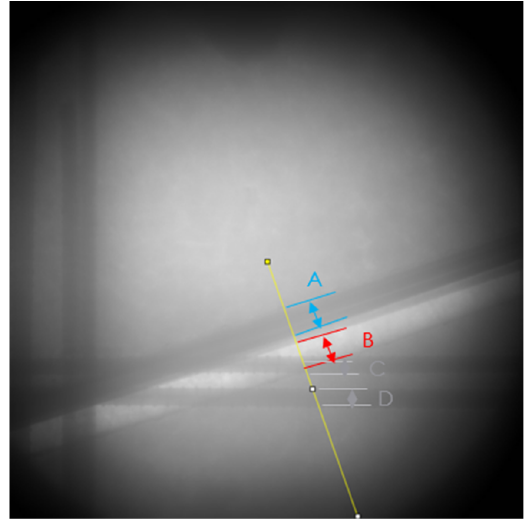
Figure 20. Gray value profile analyzing line.